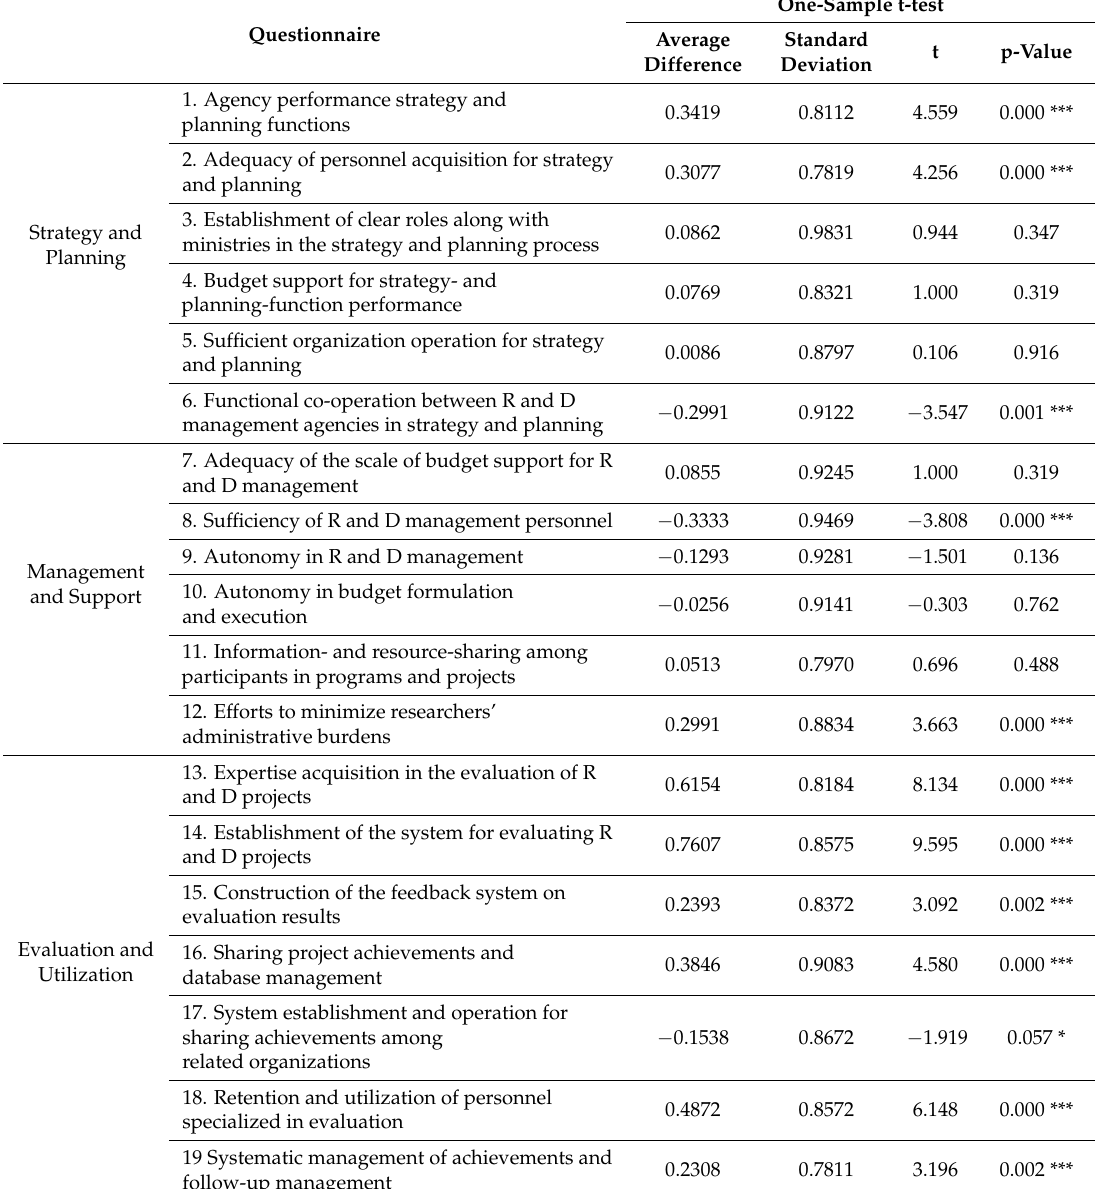
Table 4. Survey results about the major functions of R and D management